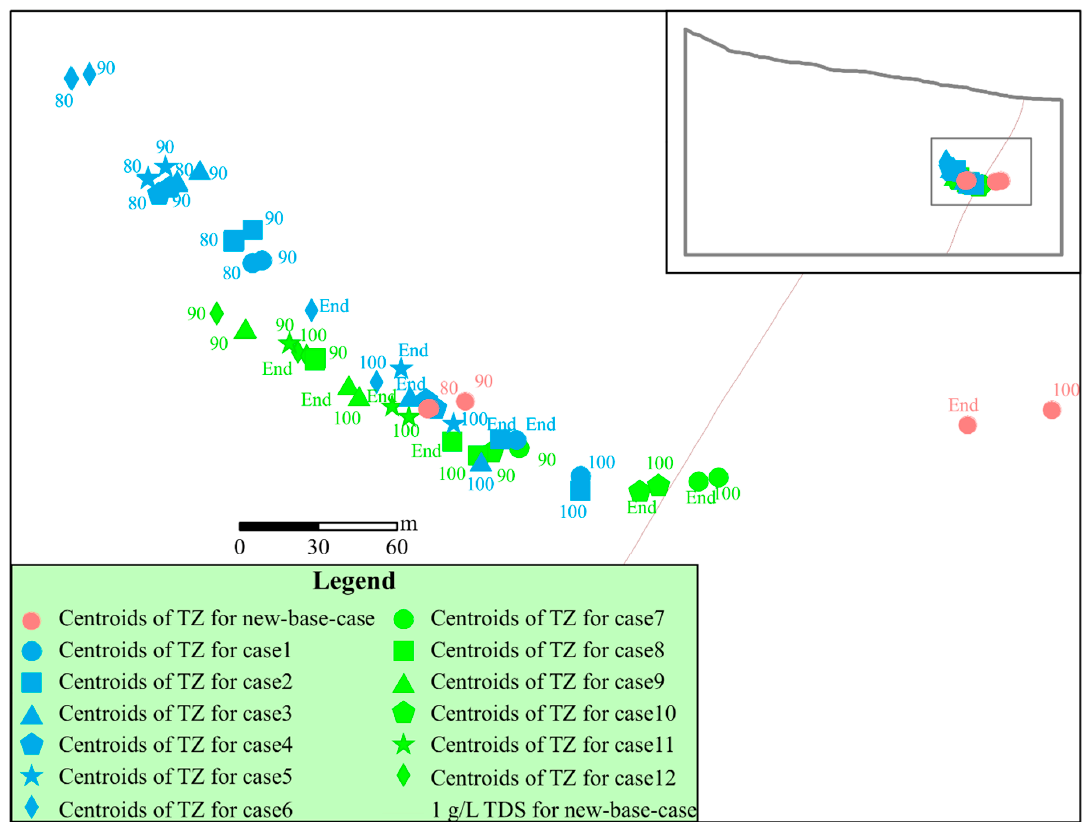
Figure 8. Centroid movement for different stages of head recovery in the heterogeneous case study (note: (1) the pink points are for the new base case, the green symbols are for cases 7–12 considering an isotropic spatial structure for the hydraulic conductivity fields, and the blue symbols are for cases 1–6 considering an anisotropic spatial structure for the hydraulic conductivity fields; (2) the labels “80”, “90”, and “100” denote the percentage of head recovery, and “End” denotes the end of the 100-year simulation).